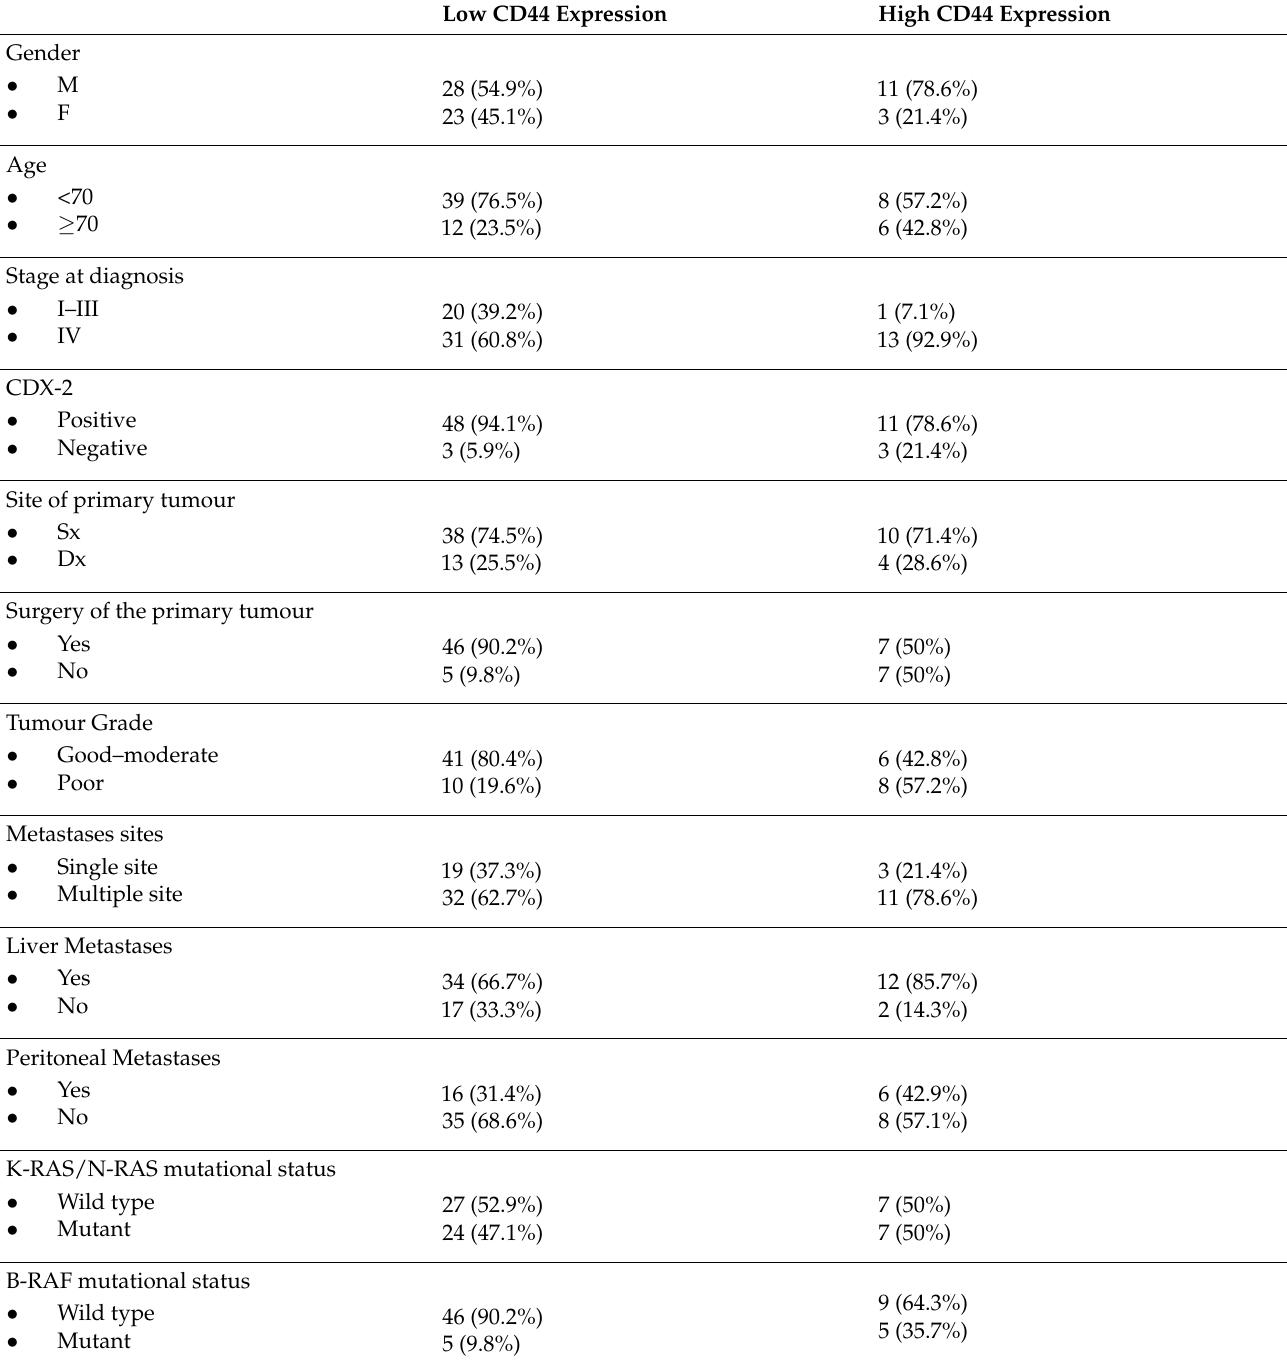
Table 2. Patient’s characteristic. Abbreviations: ECOG PS = Eastern Cooperative Oncology Group performance status; K-RAS = Kirsten rat sarcoma viral oncogene homologue; N-RAS = Neurob- lastoma RAS viral oncogene homologue B1; Anti-VEGF: anti-vascular endothelial growth factor antibodies; Anti-EGFR: anti-epidermal growth factor